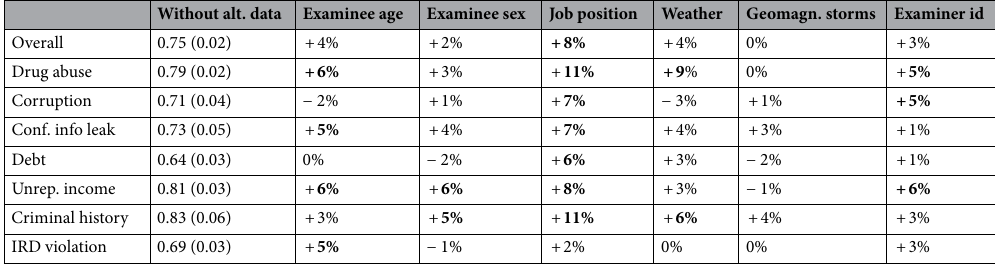
Table 5. Uplifts of AUC from each alternative data source for entire dataset, and for each topic. Significant values are in